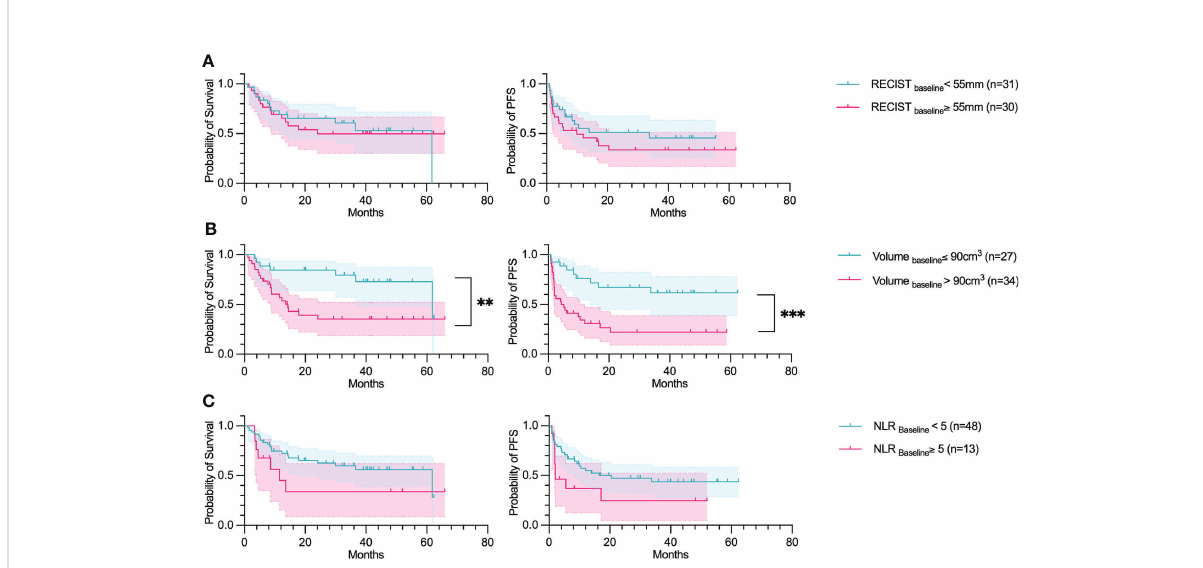
FIGURE 2 Volume baseline predicts OS and PFS. Overall survival and Progression-free survival plotted using a Kaplan Meier estimation with their respective con fi dence intervals (95%). The parameters studied are: (A) The sum of RECIST diameters (RECIST); (B) Total tumor volume (Volume); and (C) Neutrophil-to-lymphocyte ratio (NLR). For Kaplan – Meier estimation, tick marks represent data censored at the time of the last imaging assessment and statistical analyses were performed using Log-rank (Mantel-Cox) test. Symbol signi fi cance: * p ≤ 0.05; ** p ≤ 0.01; *** ≤ 0.001, **** ≤